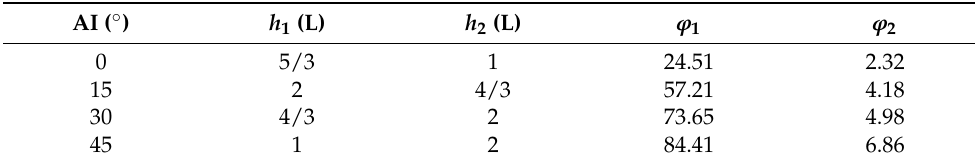
Table 1. The optimal combination of efficiency